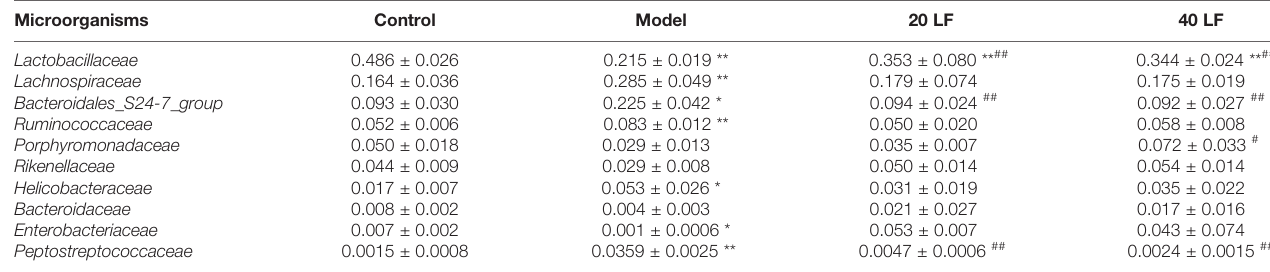
TABLE 1 | Changes of intestinal microorganisms in the top 10 relative abundance at the family level ( n = 4). Microorganisms